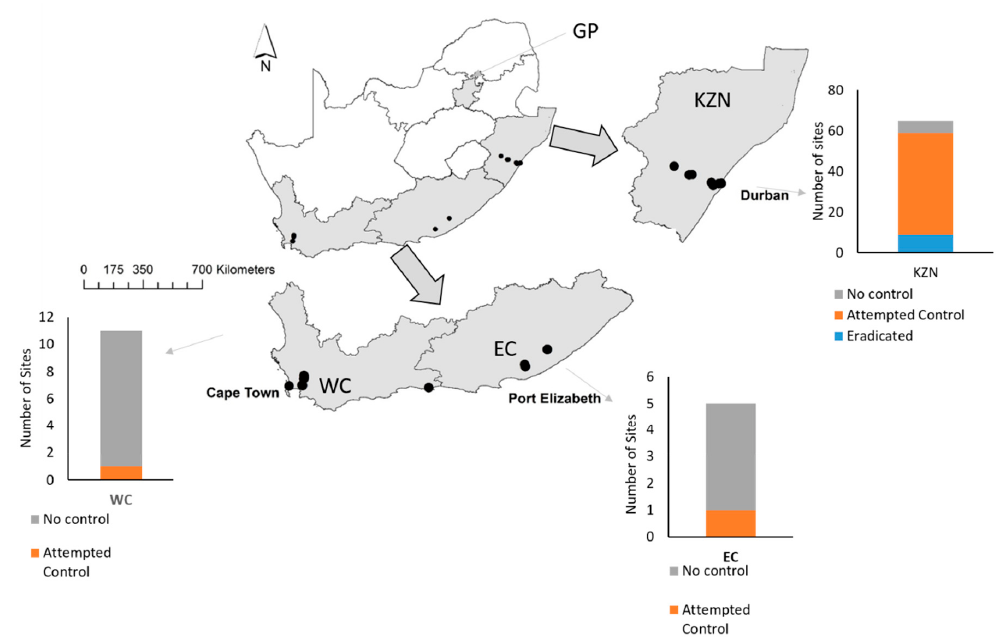
Figure 3. Sagittaria platyphylla localities (black dots) in South Africa in 2019. Gauteng (GP), KwaZulu- Natal (KZN), Eastern Cape (EC) and Western Cape (WC). Bars depict management attempts of the number of sites infested with S. platyphylla in KwaZulu-Natal (KZN), Eastern Cape (EC), Western Cape (WC), under different management techniques (herbicide application, manual and mechanical removal).